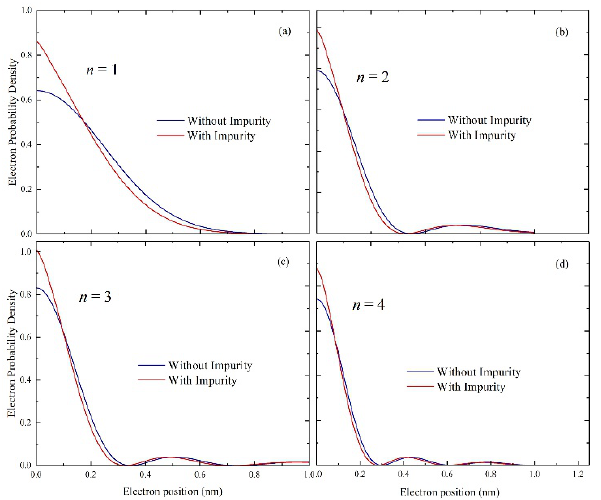
Figure 3. Distribution of the probability density of finding an electron in a QD for the first four levels of an electron with and without impurity center. ( a ) n = 1, ( b ) n = 2, ( c ) n = 3, ( d ) n =